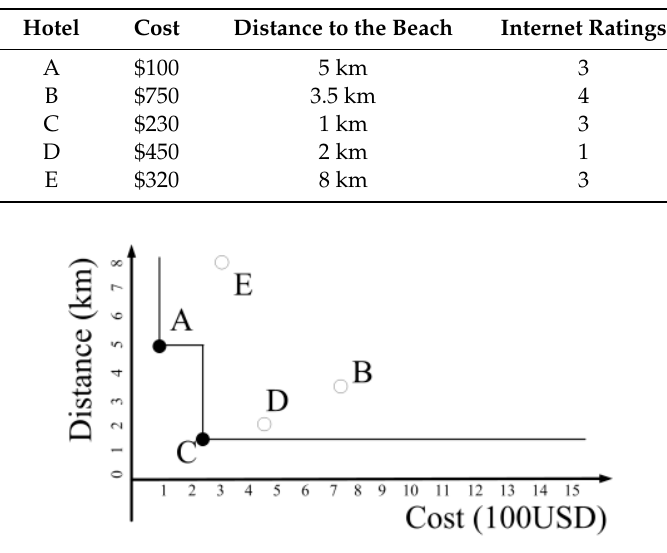
Figure 2. Theexampleof skyline hotels. Figure 2. The example of skyline